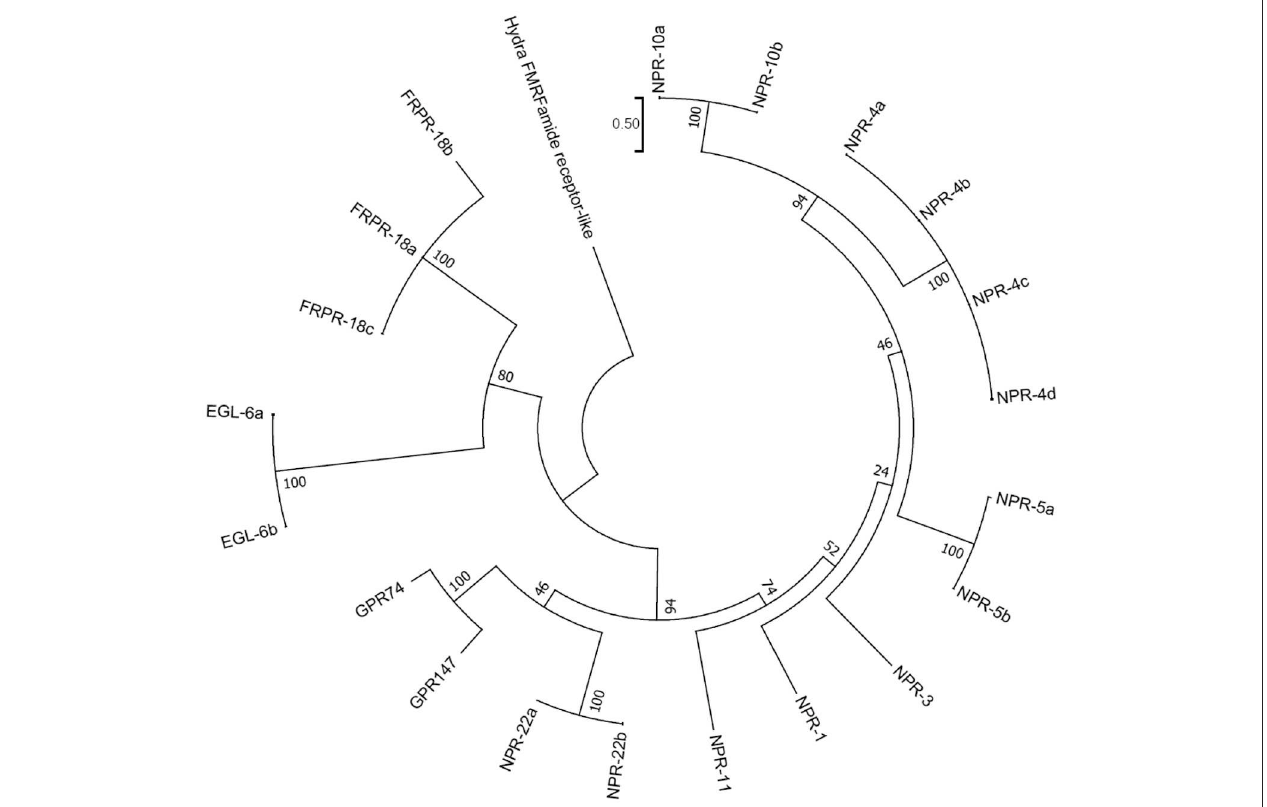
FIGURE 5 | A phylogenetic analysis of human GnIH receptors (GPR147, GPR74) and C. elegans FMRFamide-like peptide (FLP) receptors. Human GnIH receptors (GPR147, GPR74) and C. elegans FMRFamide-like peptide (FLP) receptor amino acid sequences were aligned by CLUSTALW Multiple Sequence Alignment. Multiple alignment parameters were Gap open penalty 10, Gap extension penalty 0.2, Protein weight matrix GONNET with residue-specific and hydrophilic penalties. Molecular phylogenetic analysis was performed by Maximum Likelihood method using MEGA7 (Kumar et al., 2016). The Maximum Likelihood method was based on the JTT matrix-based model (Jones et al., 1992). The tree with the highest log likelihood is shown. Initial tree for the heuristic search were obtained automatically by applying Neighbor-Join and BioNJ algorithms to a matrix of pairwise distances estimated by using a JTT model, and then selecting the topology with superior log likelihood value. The tree is drawn with branch lengths measured in the number of substitutions per site. The analysis involved 21 amino acid sequences. All positions containing gaps and missing data were eliminated. There were a total of 282 positions in the final dataset. The phylogeny was tested by 50 Bootstrap replications.